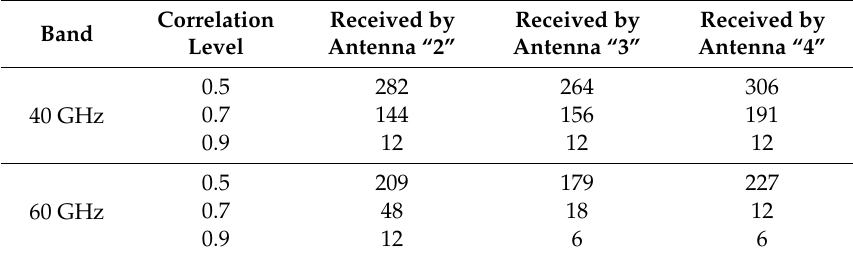
Table 5. The 99th percentile of coherence bandwidth (MHz), in the corridor, LOS.